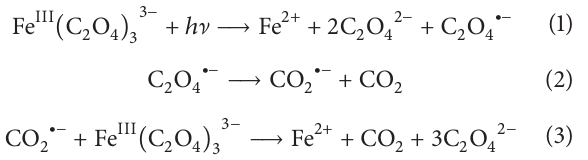
Figure 1: Chemical structure of